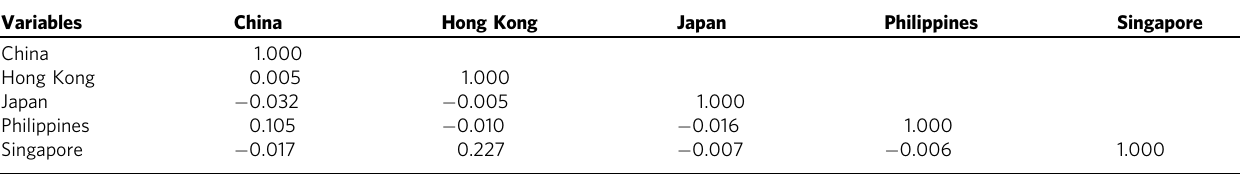
Table 2 Correlation matrix.